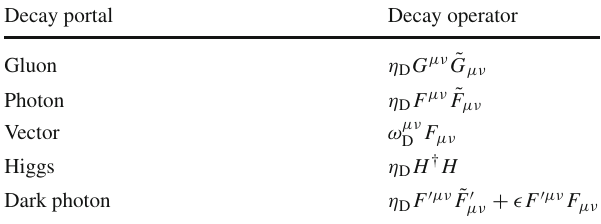
Table 1 Overview of the decay portals considered in [95]. The η D and ω D represent respectively the lightest spin-zero and spin-one meson in the dark sector, and F (cid:7) μν is the field strength for an elementary dark photon A (cid:7) . The decay portal column indicates the operator(s) that allow the unstable dark meson to decay, defining the model